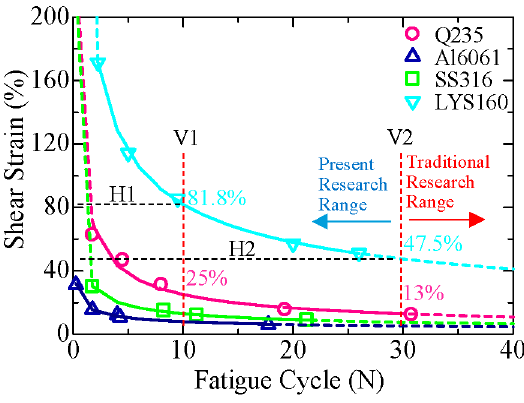
Figure 13. Fatigue curves of the test specimens.